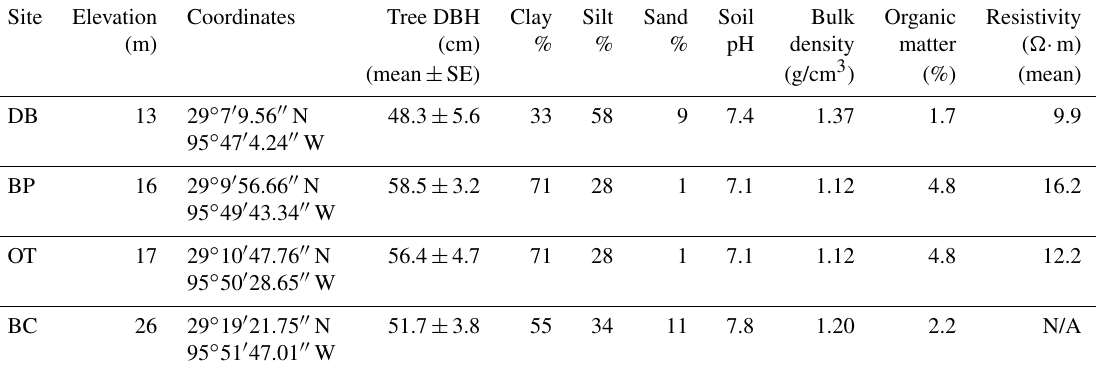
Table 1. Site description with basic soil properties (NRCS, 2020) and resistivity measurements averaged over the top 100cm depth (Guerra, 2020). Note: Dance Bayou – DB; Big Pond – BP; Otto – OT; Buffalo Creek – BC; diameter at breast height – DBH. Site Elevation Tree DBH